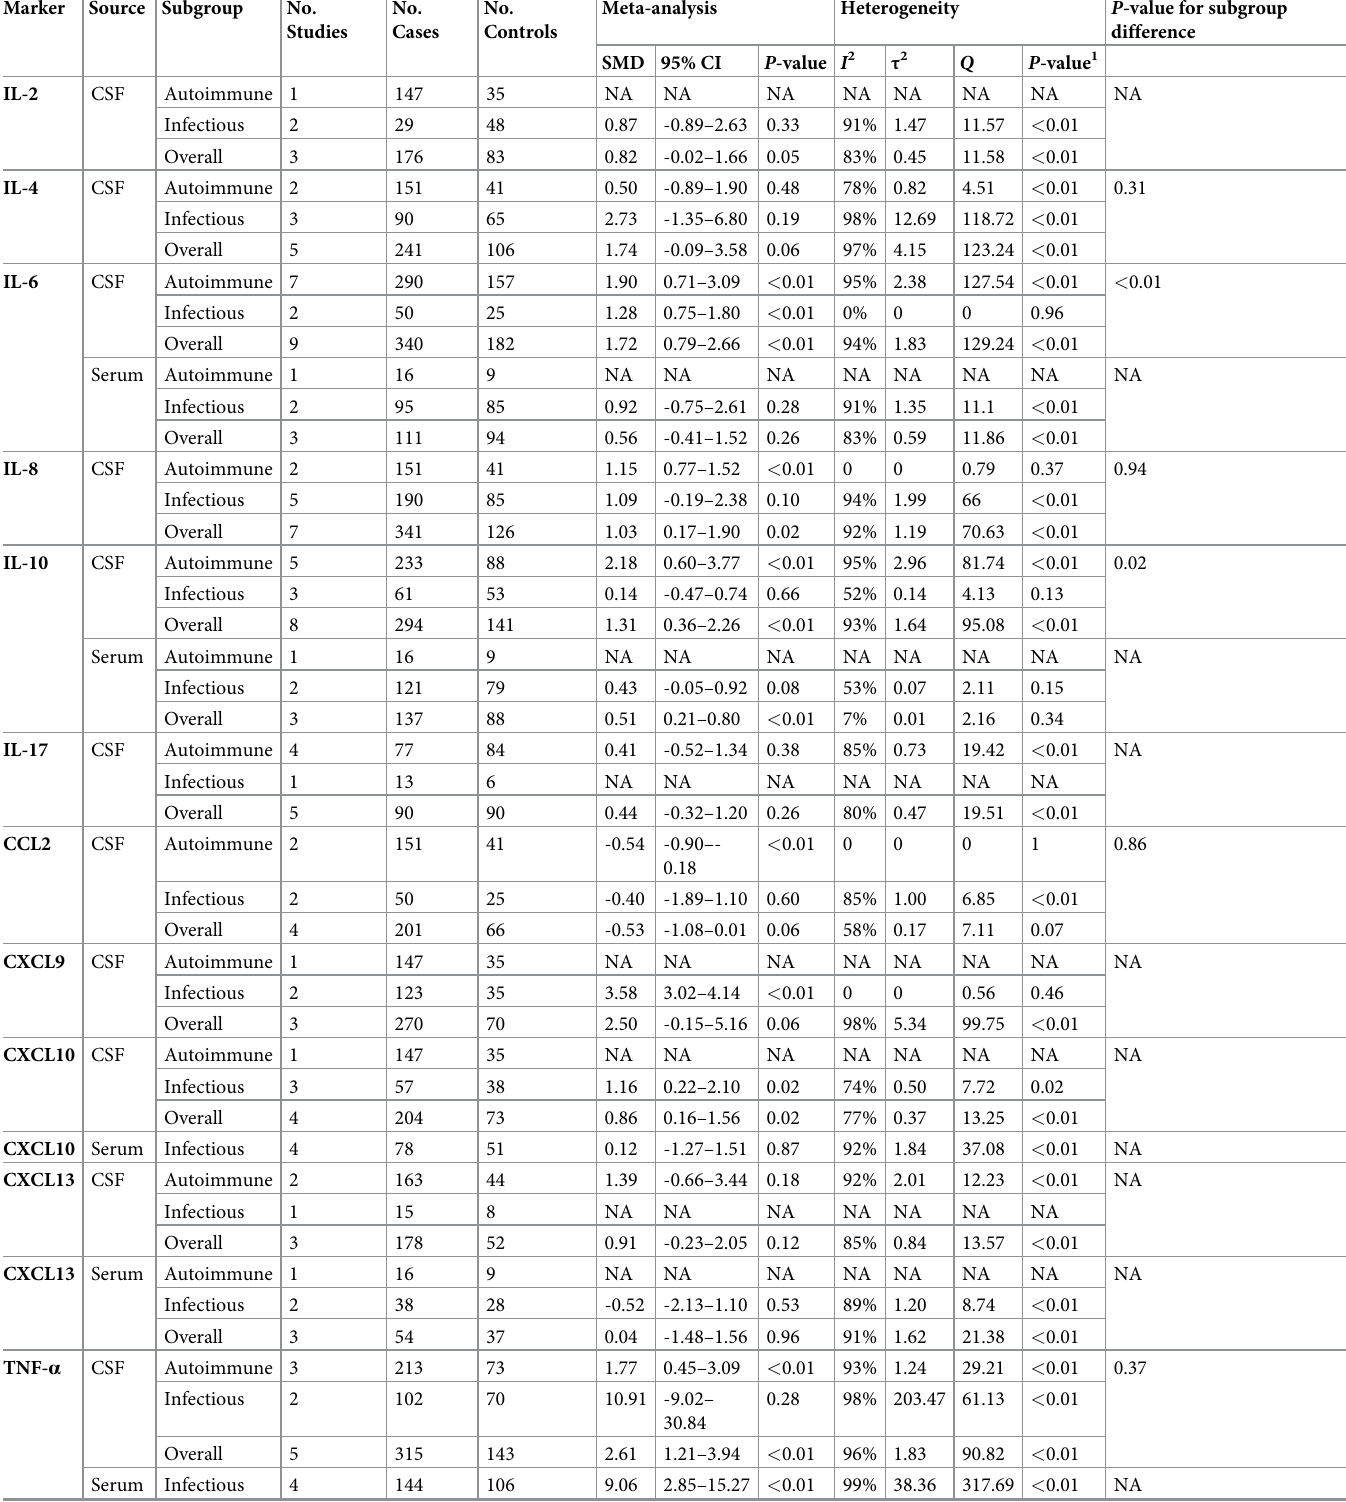
Table 3. Summary of the